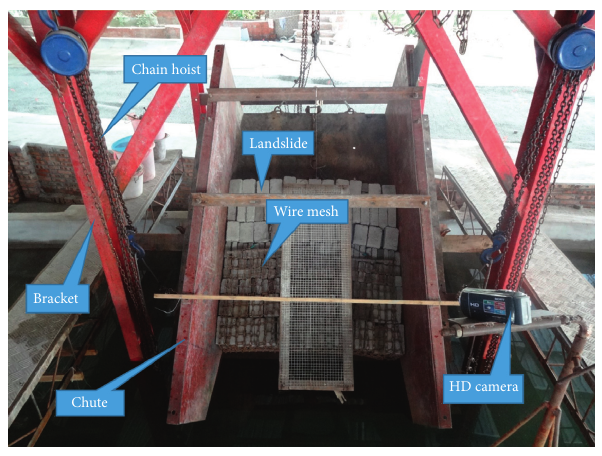
Figure 4: The wave-making system. Table 1: Sizes of concrete blocks.